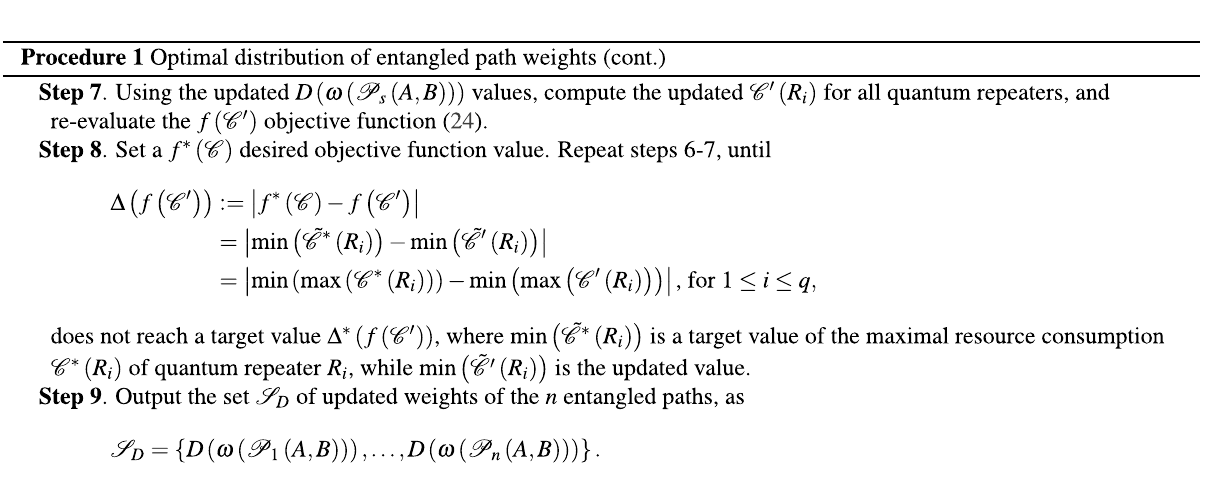
Figure 1. The schematic model of the resource consumption evaluation of a quantum repeater R i in a quantum Internet scenario. The quantum repeater has z incoming entangled connections, L l ( k ) , k S P ( R 1, 2 , that pass through quantum repeater R i between A 2 paths, P s ( A , B ) , s from among i ) = = and B . The paths P 1 ( A , B ) and P 2 ( A , B ) are associated with the weighted entanglement throughput values (cid:31) (cid:31) (cid:31) (cid:31) is the entanglement throughput (Bell states per C ) of the source A of the path P s . (The entangled states associated with the entangled connections in the quantum repeater are depicted by green, brown, and black